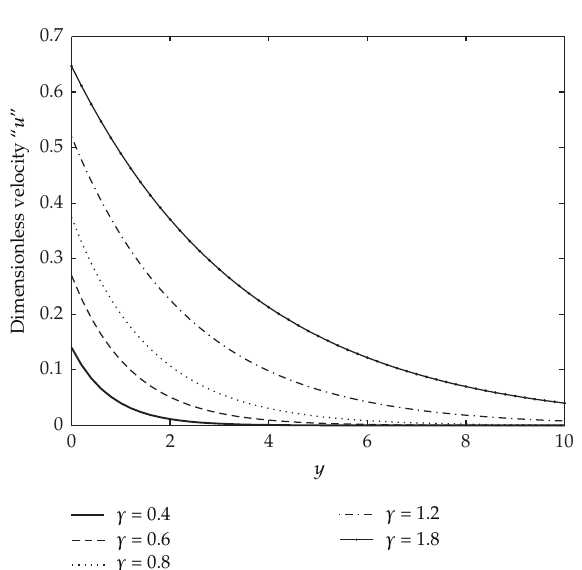
Figure 4: Backward wave-front type travelling wave solution (cid:3) 4.12 (cid:4) varying γ when β (cid:8) 3, c (cid:8) 1, and t (cid:8) π/ 2 are